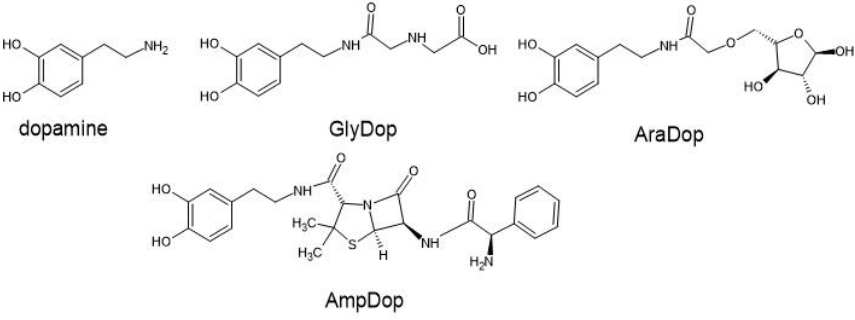
Figure 9. Structures of dopamine and dopamine derivatives in this